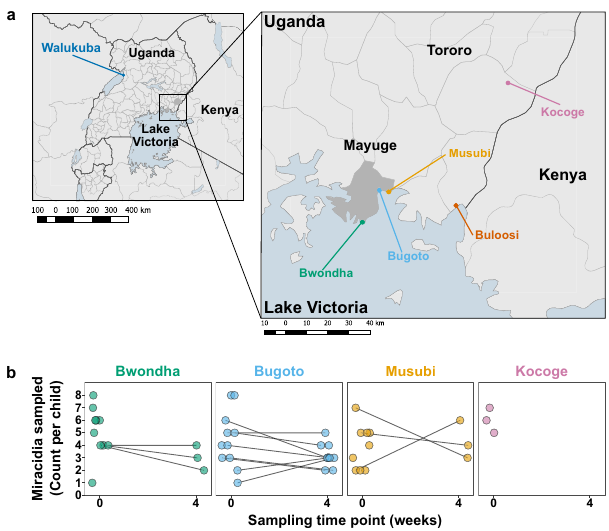
Fig. 1 Study design and summary of miracidia stage samples sequenced. a Sampling was performed in two districts in Uganda; Mayuge district and Tororo district. Within those regions four schools were selected, three from Mayuge district which borders Lake Victoria: Bwondha (green), Bugoto (light blue) and Musubi (yellow). One school from the Tororo district, close to the Kenya border, was chosen: Kocoge (pink). Mayuge district and Tororo district primary schools in each region have been under long-term and short-term mass drug administration (MDA) pressure, respectively. b Pre- and post-treatment sampling information. Circles indicate the numbers of miracidia sampled at week 0 (immediately before treatment) and 4 weeks post-treatment, lines indicate miracidia sampled at both time points from the same children, only samples passing read sequence quality control are and child age ( R 2 = 0.051, p = 0.2, Supplementary Fig. 8c),